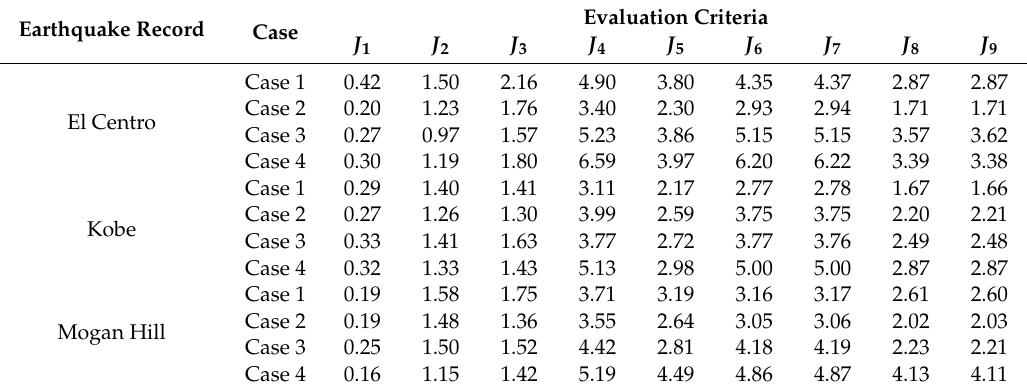
Table 6. Mean of evaluation criteria for perturbed cases.